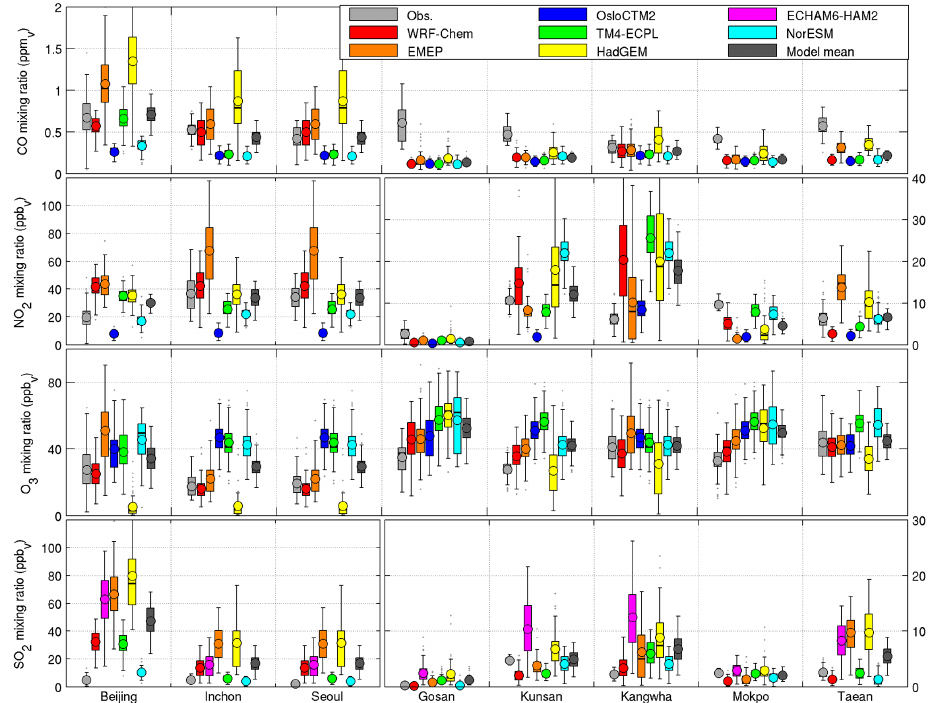
Figure 5. Box-and-whisker plots showing (from top to bottom) CO, NO 2 and ozone, and SO 2 mean (circle), median (central line), the 25th and 75th percentile (box edges) concentrations in volume mixing ratios during August and September 2008, as observed and simulated at eight surface sites in east Asia. The whiskers encompass values from the 25th − 1.5 × (75th–25th) to the 75th + 1.5 × (75th–25th). This range covers more than 99% of a normally distributed data set. Note the different scales between urban (three left) and rural (five right) stations for NO 2 and SO 2